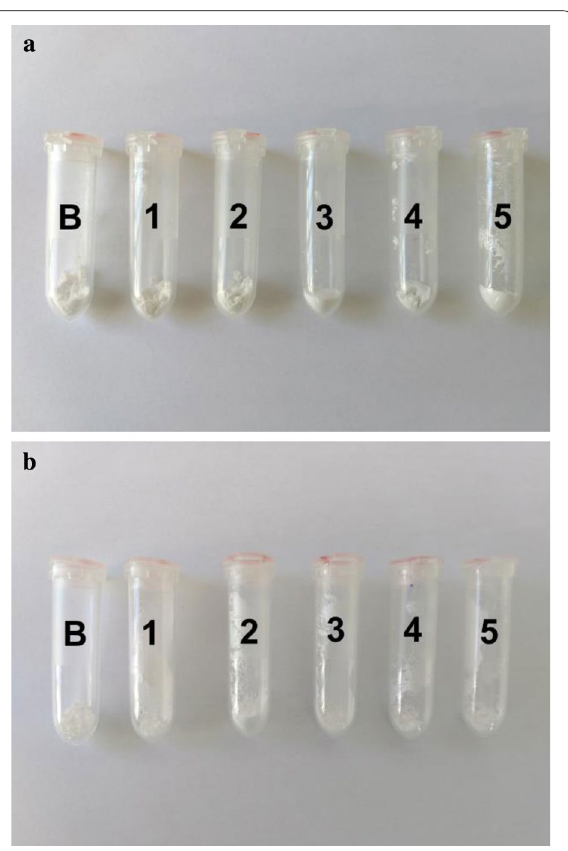
Fig. 3 Matrices after a period of 24 h of rhynchophorol adsorption: a Na-magadiite; b zeolite